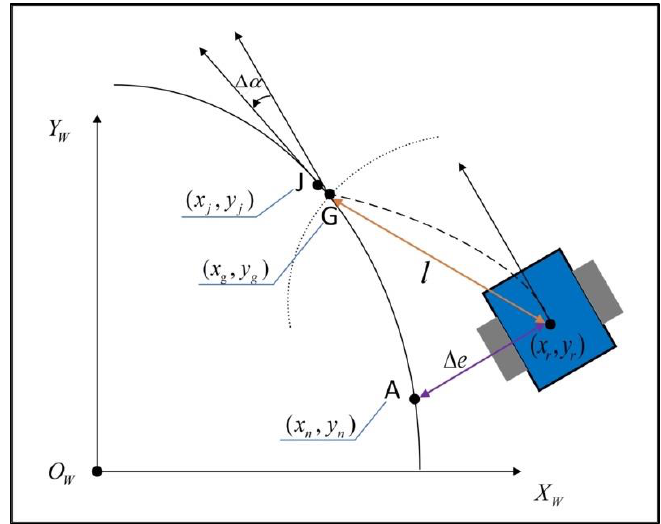
Figure 7. Turning controller geometry.